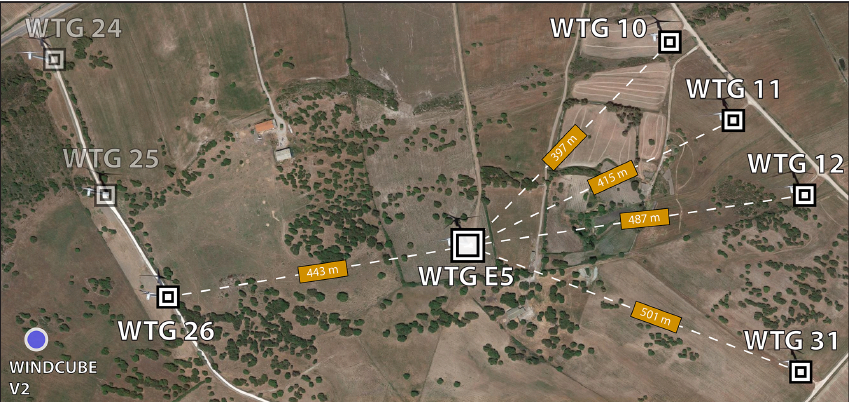
Figure 1. Positions of the wind turbines used in the wake-steering campaign. Turbines WTG 26 and E5 are operated at a yaw misalignment to steer the wakes away from downstream turbines WTG E5, 10, 11, 12, and 31. WTG 25 is used for normalization. WTG E5 is a GE 1.5sle turbine, and all others are GE 1.5s turbines. A WindCube V2 lidar system is used to characterize the inflow in front of WTG 26 for a short